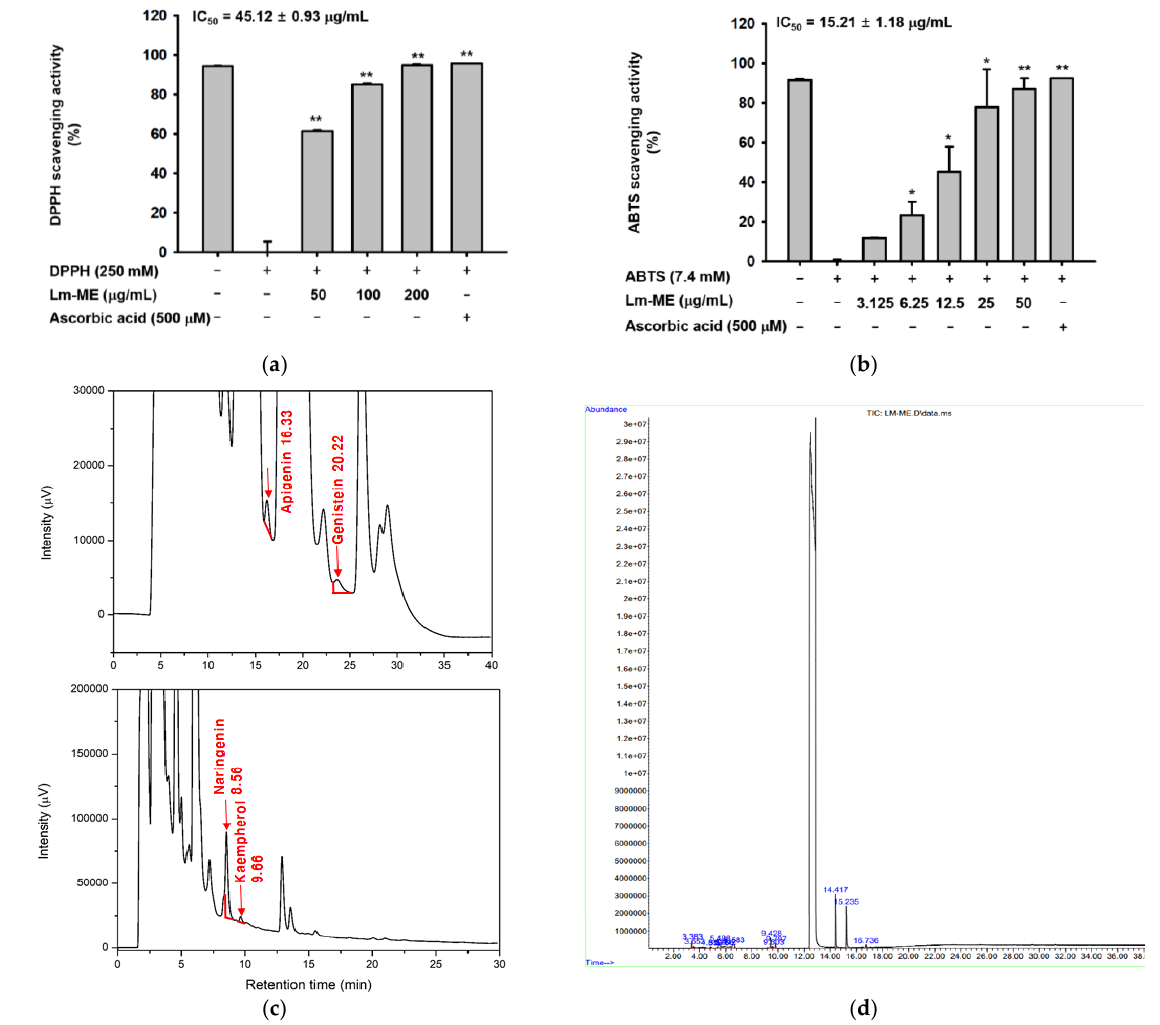
Figure 1. The antioxidative activity of Lm-ME and its phytochemical fingerprinting profiles. ( a , b ) DPPH and ABTS assays were performed to confirm the ROS scavenging activity of Lm-ME. Ascorbic acid (500 µ M) was used as a positive control. ( c ) The phytochemical fingerprinting profiles of Lm-ME using HPLC analysis. ( d ) Qualitative analysis of Lm-ME using GC/MS analysis. *: p < 0.05 and **: p < 0.01 compared to the control group (DPPH or ABTS